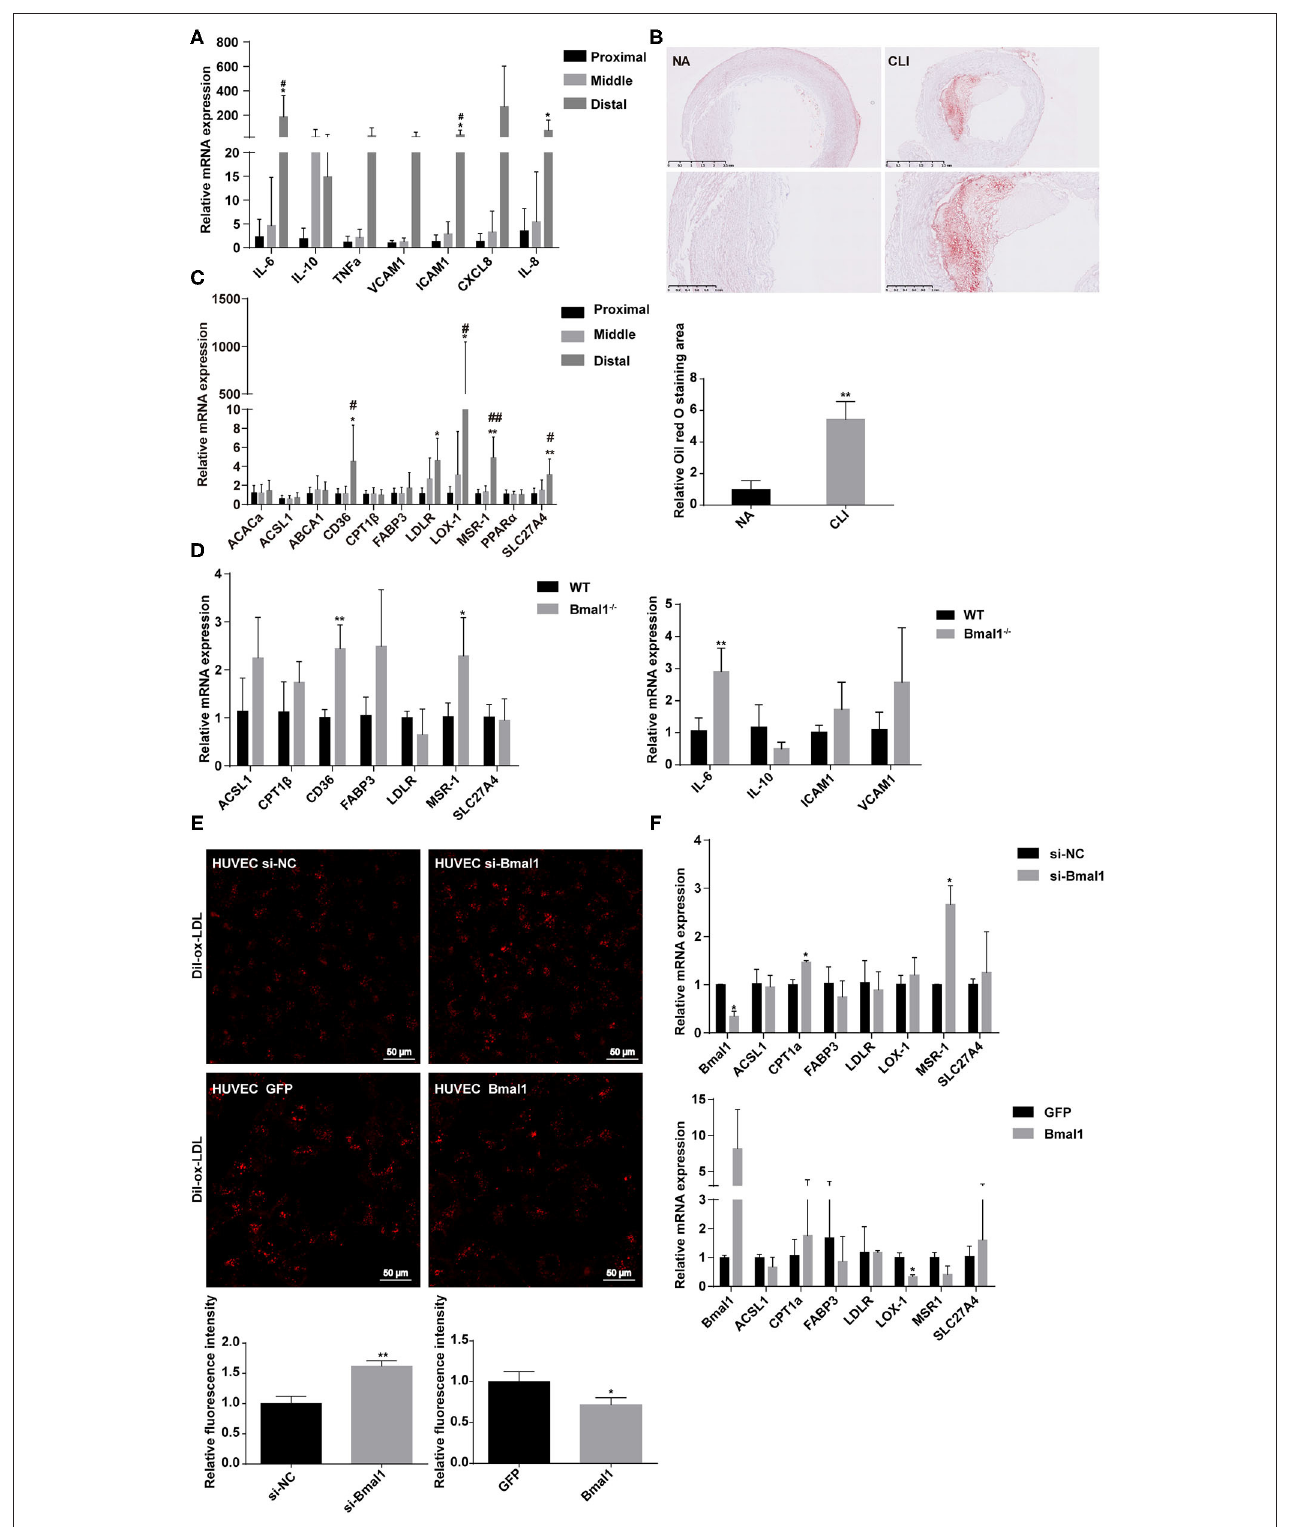
FIGURE 2 | Bmal1 inhibits lipid uptake by endothelial cells. (A) Relative mRNA expression of inflammation factors by real-time PCR. Data are presented as mean ± SEM ( n = 9, one-way ANOVA with post-hoc Tukey test). * p < 0.05 distal lower limb vs. proximal lower limb; # p < 0.05 distal lower limb vs. middle lower limb. (B)